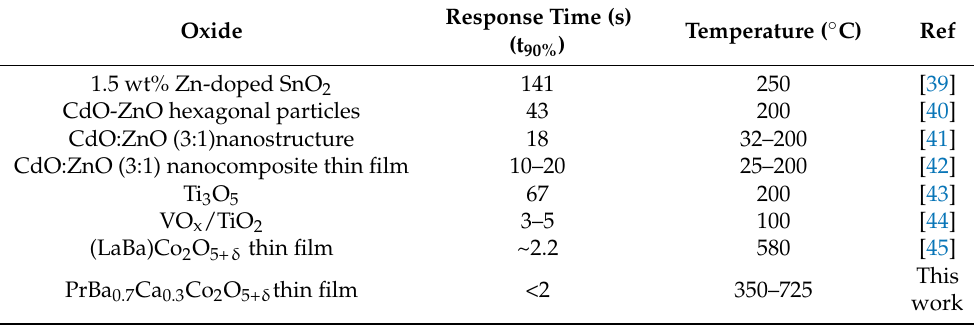
Table 2. Features of medium- and high-temperature oxygen sensors based on various semiconductor oxides. Response Time Oxide